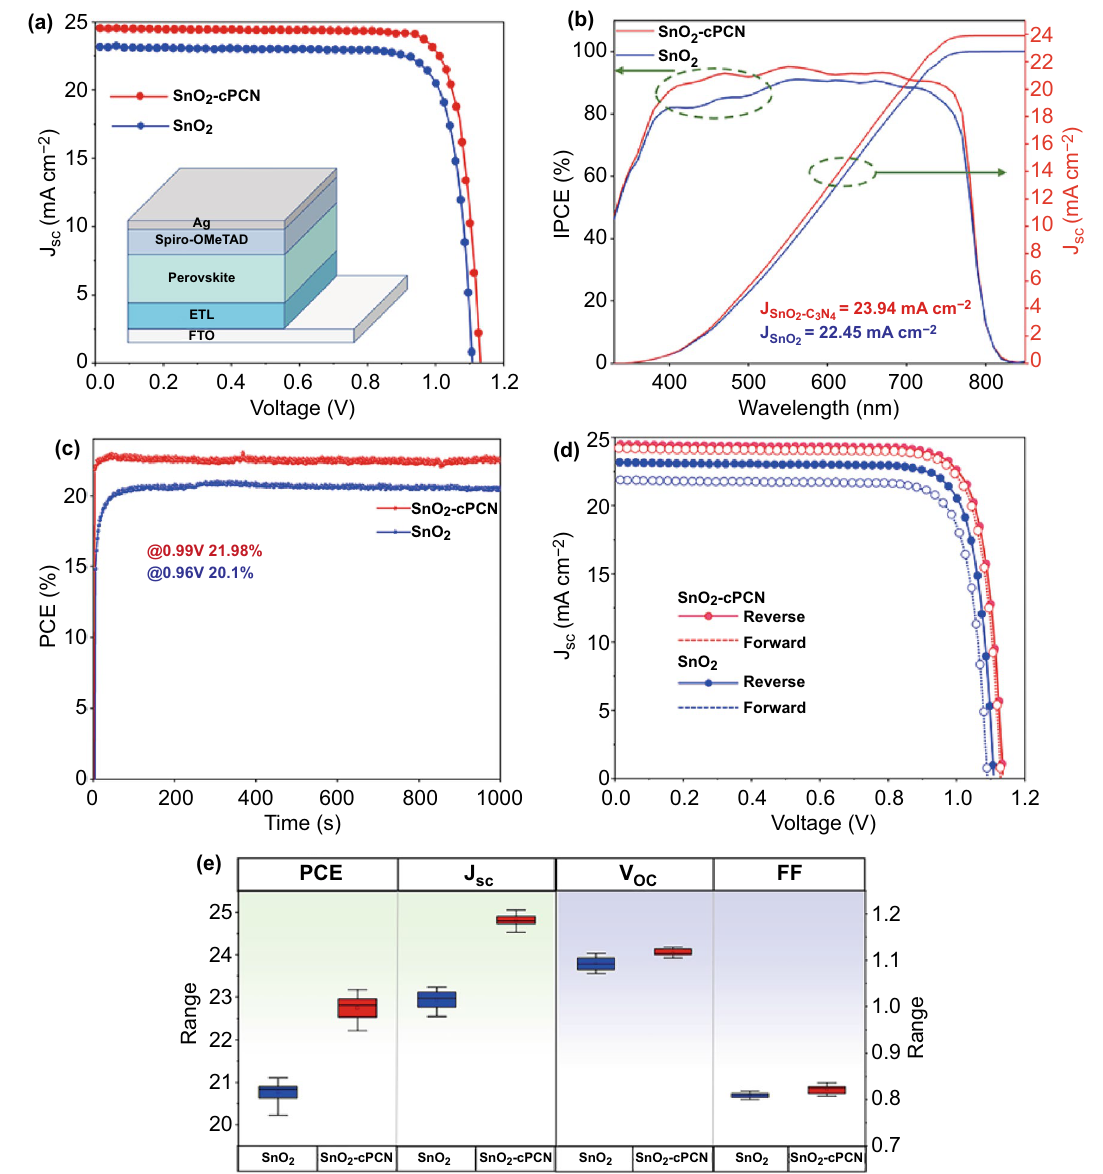
Fig. 4 a J–V characteristics for champion PSCs based on the SnO 2 and SnO 2 -cPCN ETLs under the illumination of 1 sun (AM 1.5 G). b Cor- responding EQE curves and integrated current density of the two champion PSCs. c The stabilized power output of the fabricated PSCs on the SnO 2 -cPCN and SnO 2 ETL at the maximum power point (MPP) at 0.99 and 0.96 V. d J–V curves of both champion devices for both forward and reverse scans. e Distribution of photovoltaic parameters of the two kinds of solar cells (20 devices for each